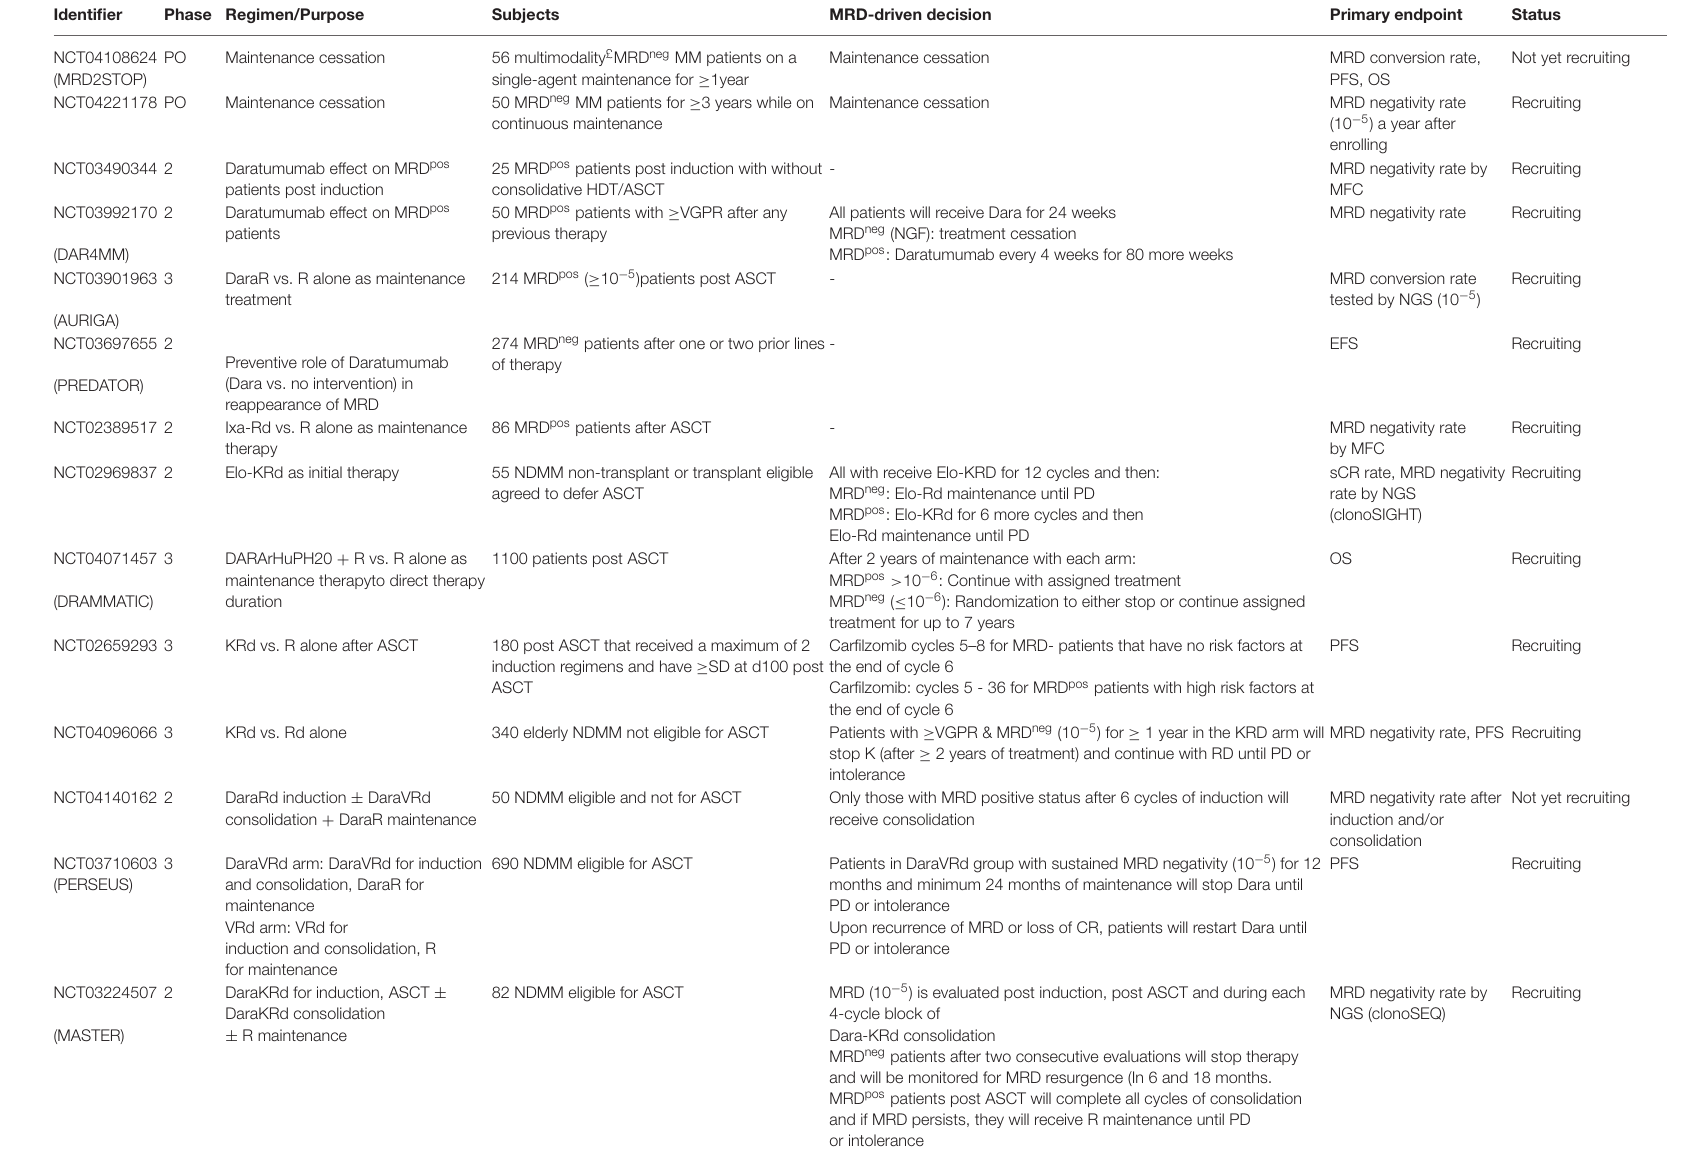
TABLE 3 | Ongoing clinical trials including MRD status in patients’ enrollment and/or MRD-driven